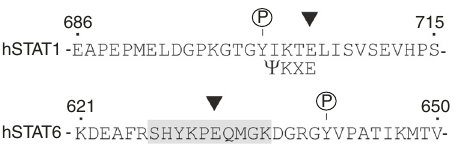
Fig. 1 The purported ADP-ribosylation site of STAT1 is not conserved for STAT6 and overlaps with the SUMO consensus sequence. Amino acid sequences fl anking the phosphorylation site of human STAT1 (top) and human STAT6 (bottom). The phosphorylated tyrosyl residues are indicated by P (in circles). Proposed ADP-ribosylation sites are indicated by black triangles. The canonical SUMO consensus sequence ψ -K-X-E ( ψ , a hydrophobic amino acid; K, SUMO acceptor, X, any amino acid residue) is given underneath the respective STAT1 sequence. The proposed ADP- ribosylated STAT6 peptide is highlighted by a gray